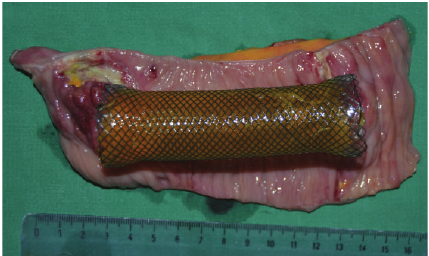
Figure 7: Segmentary enterectomy: postresection specimen and metallic stent.